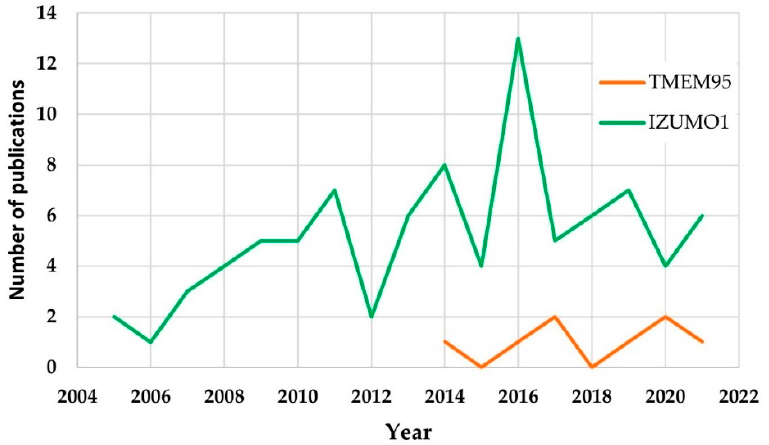
Figure 2. The number of publications as a function of the year (March 2005–May 2021), including all the articles from the database created after the application of inclusion and exclusion criteria for IZUMO1 (green) and TMEM95 (orange).